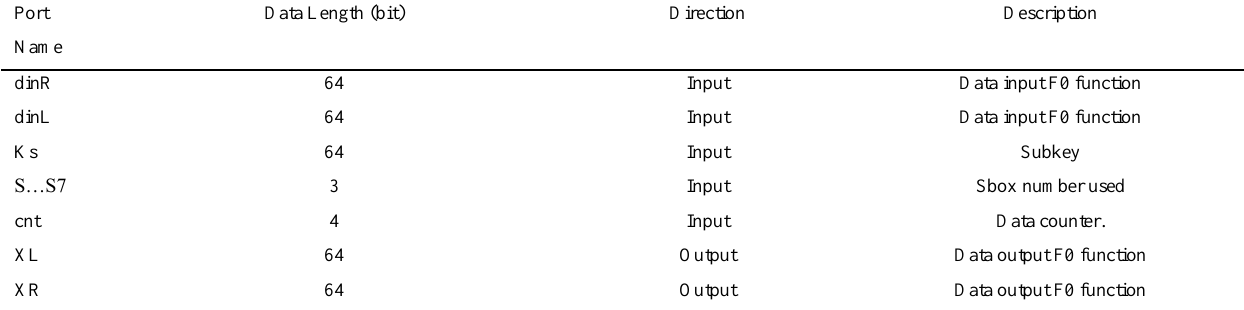
Table 16. F0 module pinout